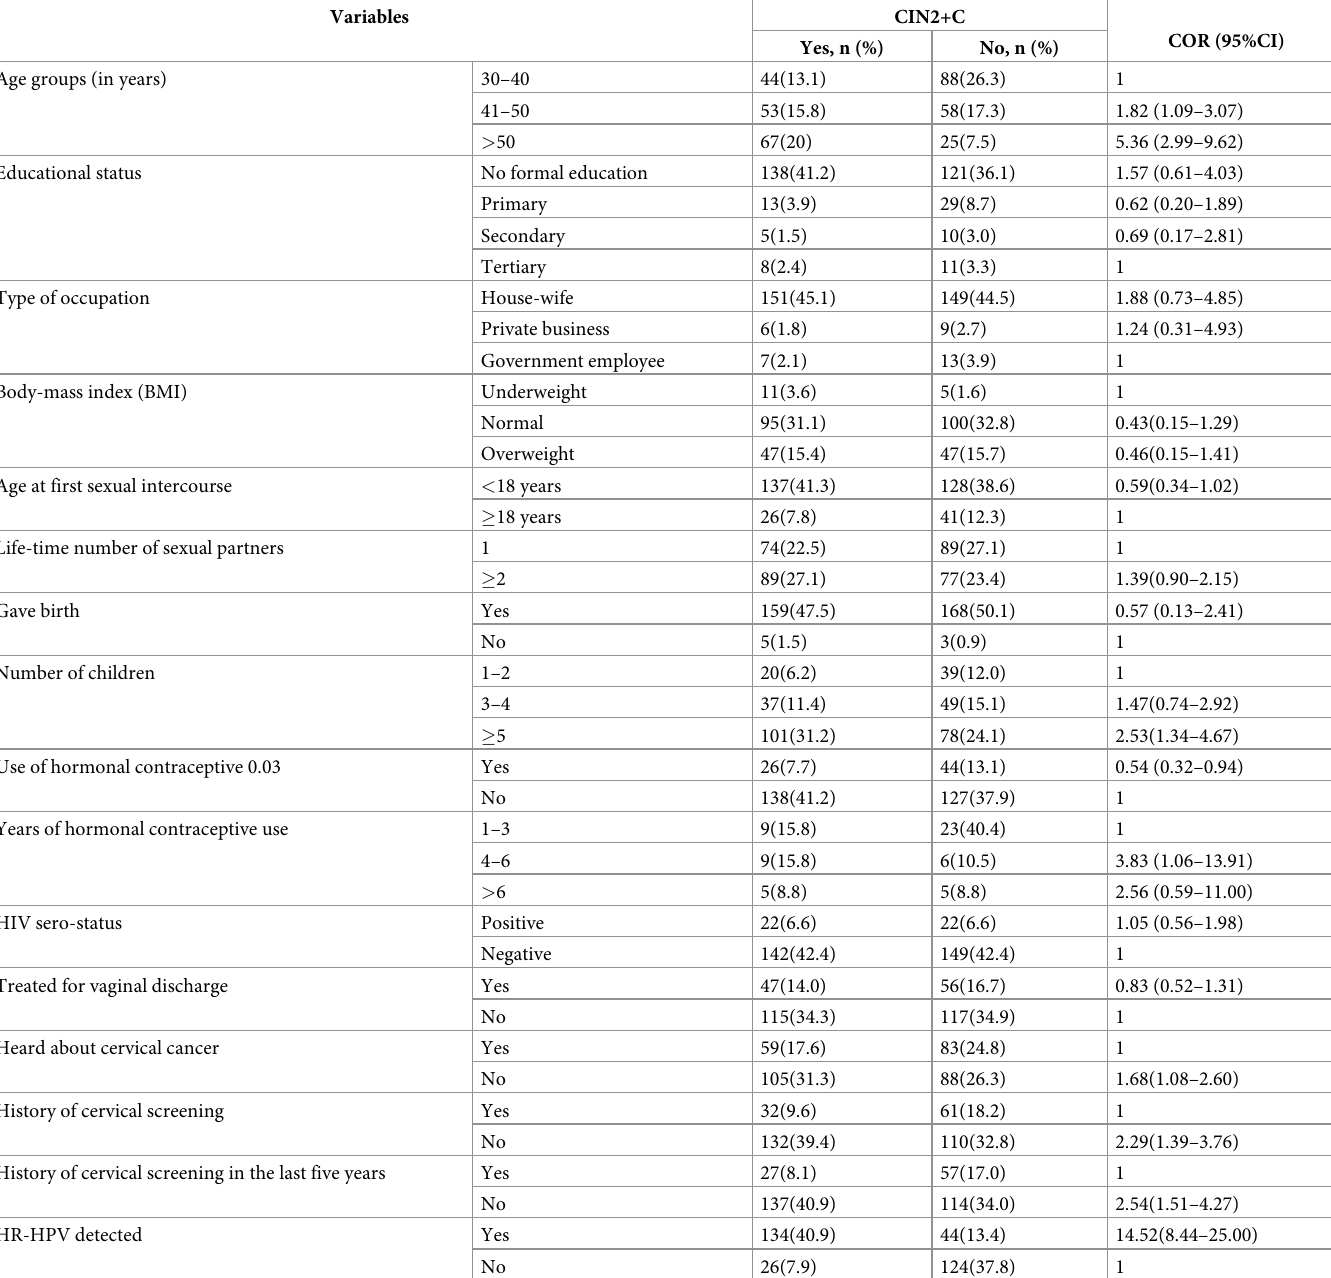
Table 2. Bivariable logistic regression analysis of factors associated with high-grade and cancerous lesions